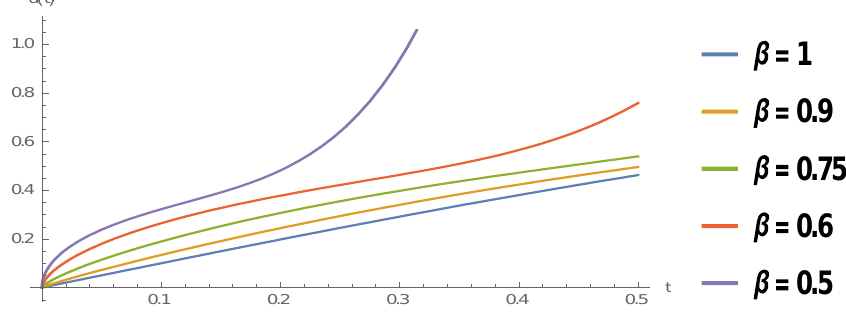
Figure 2. The behavior of the approximate solutions u ( t ) , t ∈ I = [ 0, 0.5 ] of problems (32) and (33).